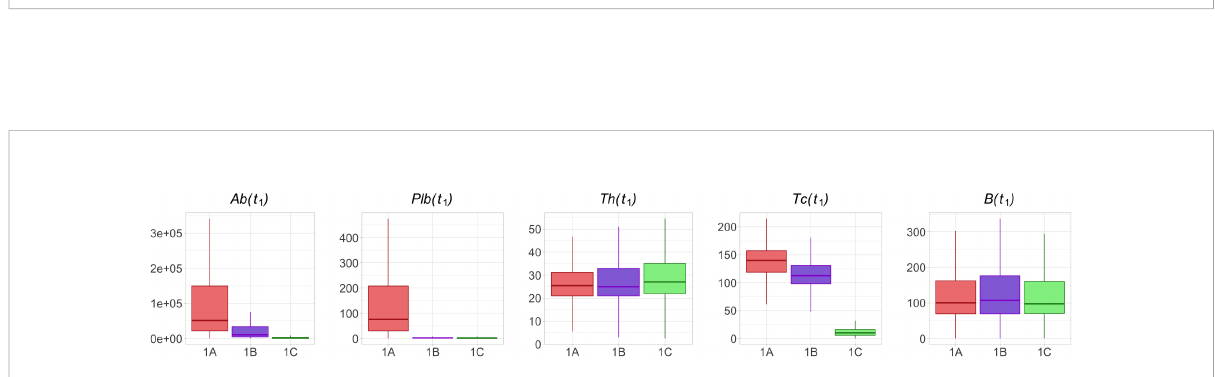
FIGURE 5 Th and B are not signi fi cantly different in protocols 1A, 1B and 1C at time t 1 , whereas Ab, Plb and Tc are lower in the longer protocols. The box plots show the median, IQR, and range of Ab, Plb, Th, Tc and B in treatment groups 1A, 1B and 1C at time t 1 .